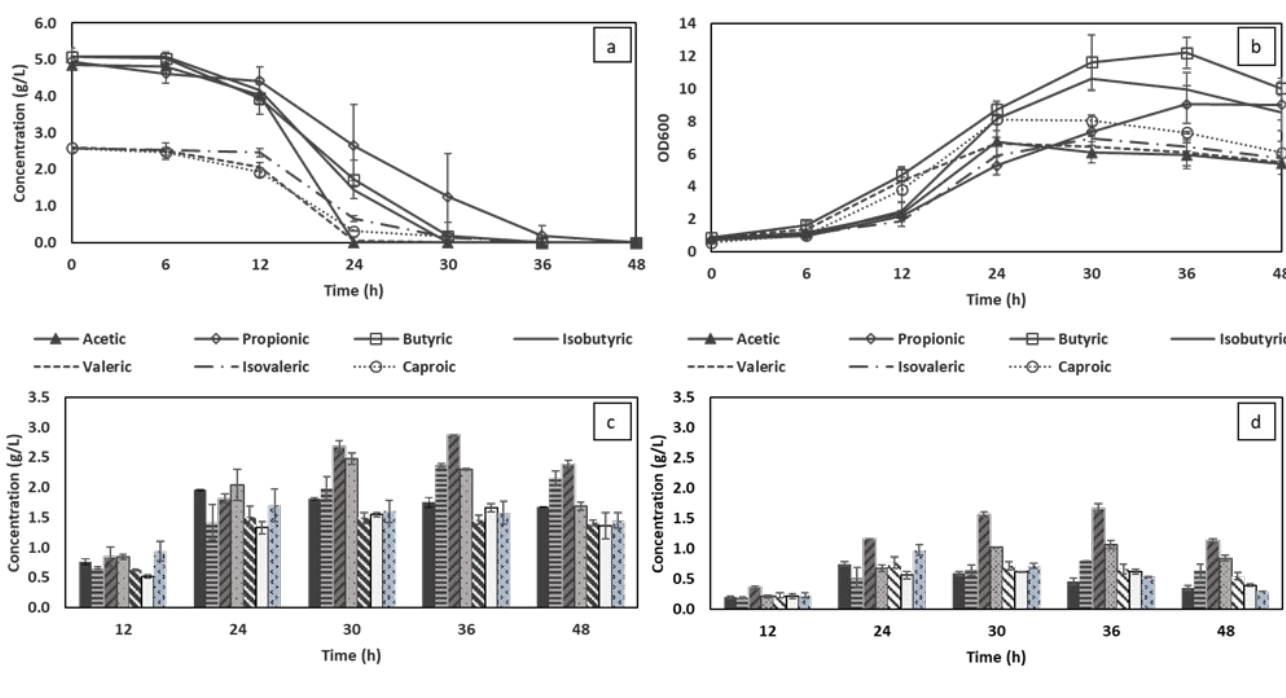
Figure 5. Changes in individual volatile fatty acid (VFA) consumptions ( a ) and cell density ( b ) corresponding to biomass production ( c ) and PHA accumulation ( d ) during bioreactor cultivation under optimal conditions.